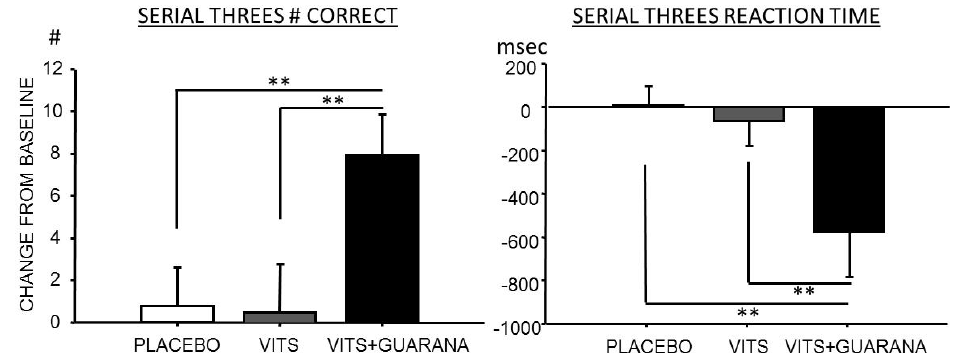
Figure 1. Effects of vitamin-minerals alone (VITS) and with guaraná (VITS + GUARANÁ) on Serial Threes performance compared with a placebo. Graphs depict means with SEM. ** p < 0.01.